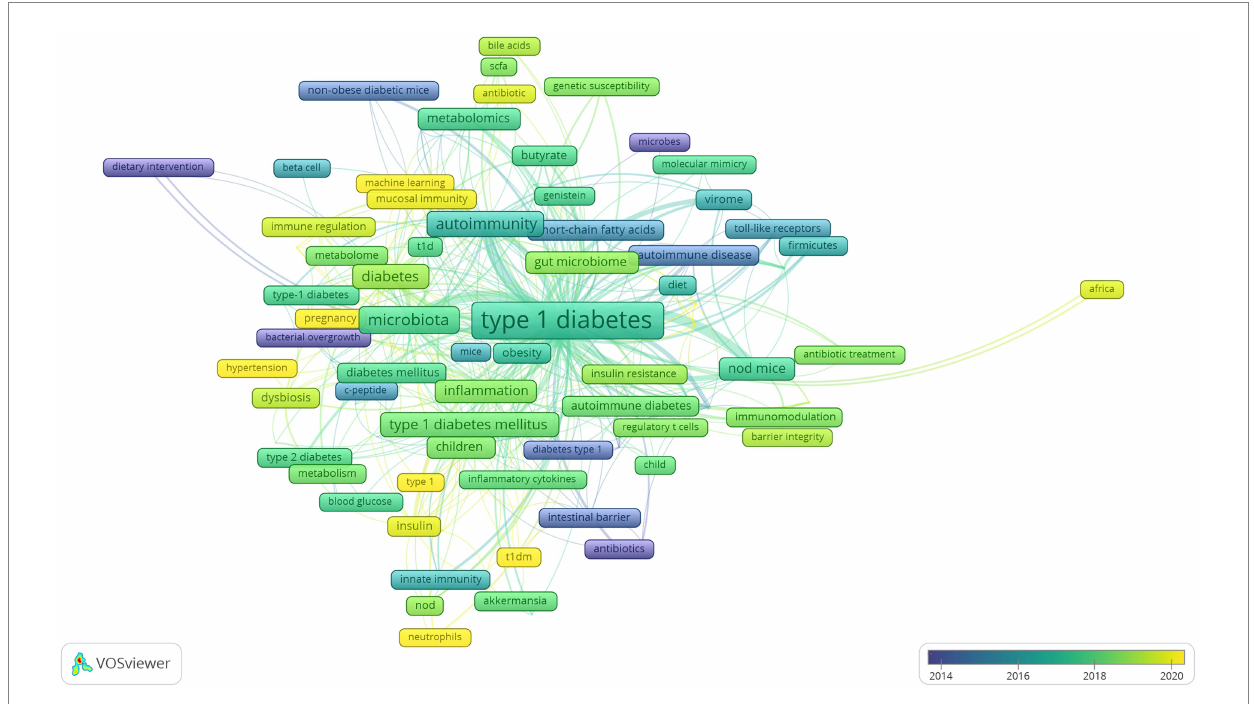
FIGURE 9 Developing trends of high-frequency